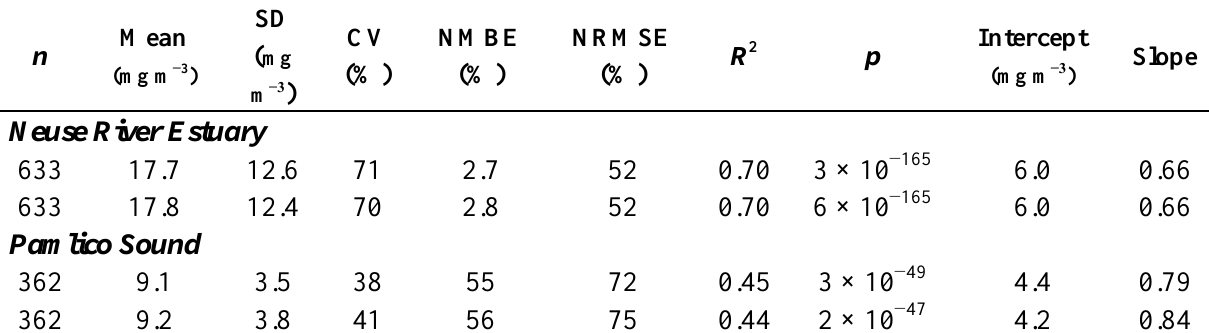
Table 1. Validation results of predicted (MERIS) versus measured (FerryMon) Chl concentrations for the Neuse River Estuary and Pamlico Sound both with (upper rows) and without (lower rows) atmospheric correction. The columns from the left to the right mean the sample size ( n ), measured mean, standard deviation (SD), coefficient of variation (CV), normalized mean biased error (NMBE), normalized root-mean-squares error (NRMSE), determination coefficient ( R 2 ), significance level ( p ), intercept and slope.